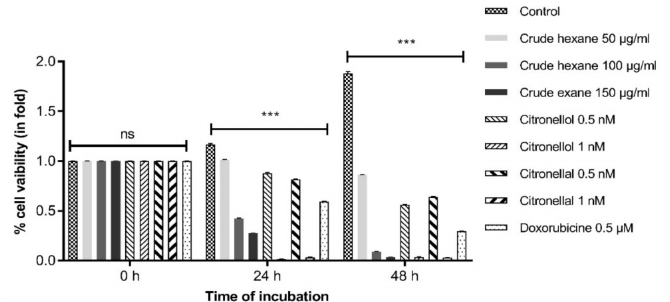
Figure 2. Crude hexane extract, citronellol, and citronellal reduced MDA-MB-231 cell proliferation at both 24 h and 48 h. Data are presented as means ± SEM. One-way ANOVA with Dunnett’s multiple comparisons test was used to analyze the di ff erence between control and treatment groups, p value < 0.05 considered significant (*** p <